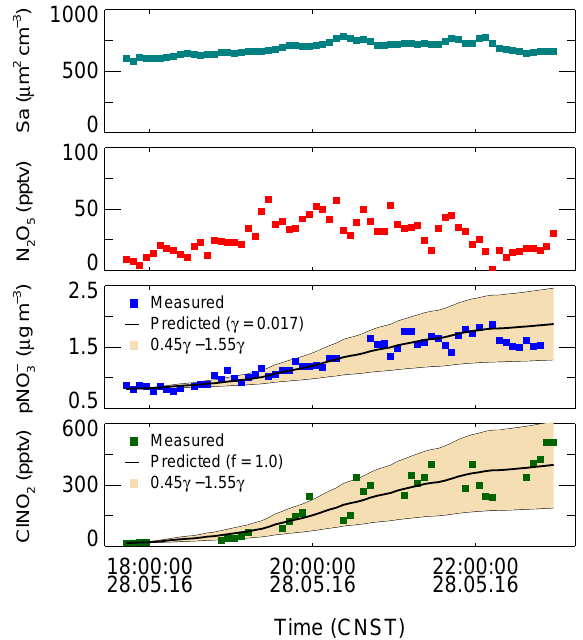
Figure 5. The best fit of γ and f to reproduce the observed ClNO 2 and p NO − with an offset on 28 May. The black lines are the pre- 3 dicted results of the integrated NO − and ClNO 2 by using the ob- 3 served S a and N 2 O 5